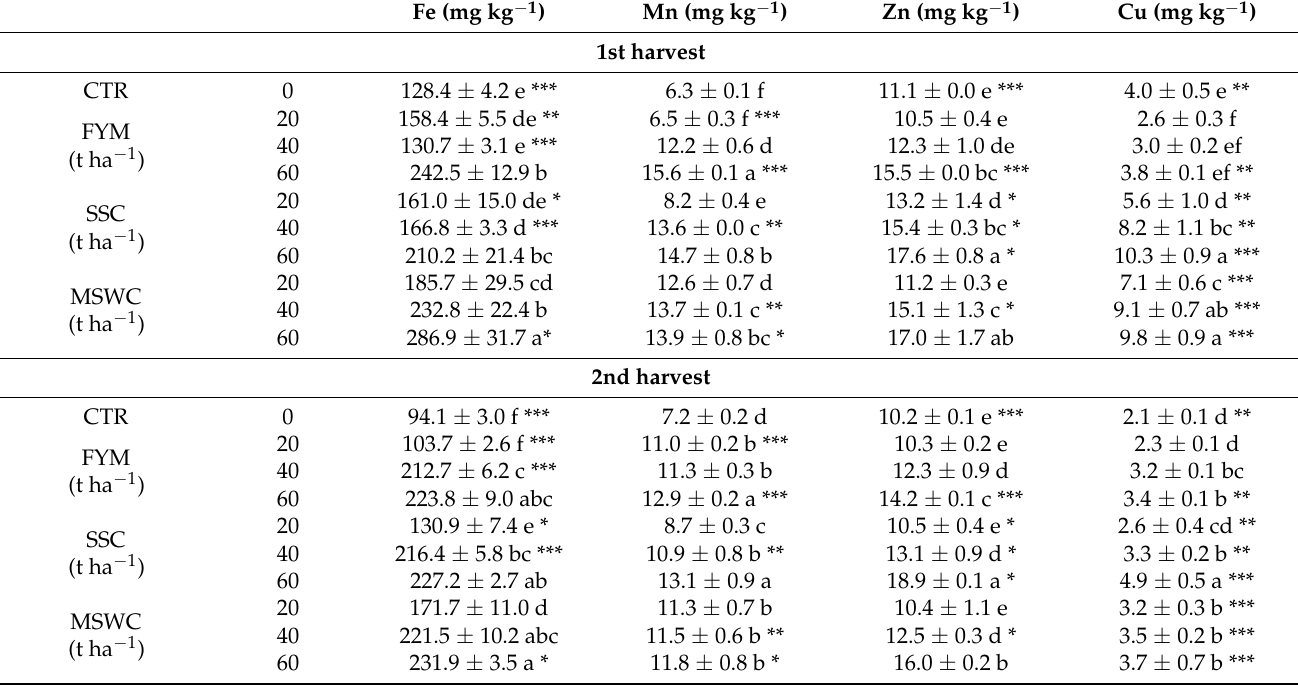
Figure 7. Effects of the soil amendment with different doses (20, 40, 60 t ha − 1 ) of farmyard manure (FYM), sewage sludge compost (SSC) or municipal solid waste compost (MSWC) on K, Ca and Mg concentrations in barley stems. CTR: unamended soil. Lower case letters indicate significant differences between treatments within the same harvest time. Asterisks indicate significant differences between harvest time within each treatment over time (* p < 0.05). Table 2. Effects of the soil amendment with different doses (20, 40, 60 t ha − 1 ) of farmyard manure (FYM), sewage sludge compost (SSC) or municipal solid waste compost (MSWC) on some micronutrient concentrations in stems of barley plants (mean, n = 3). CTR: unamended soil. Lower case letters indicate significant differences between treatments within the same harvest time. An asterisk indicates significant differences between harvest time within each treatment over time. * p < 0.05, ** p < 0.01, *** p <